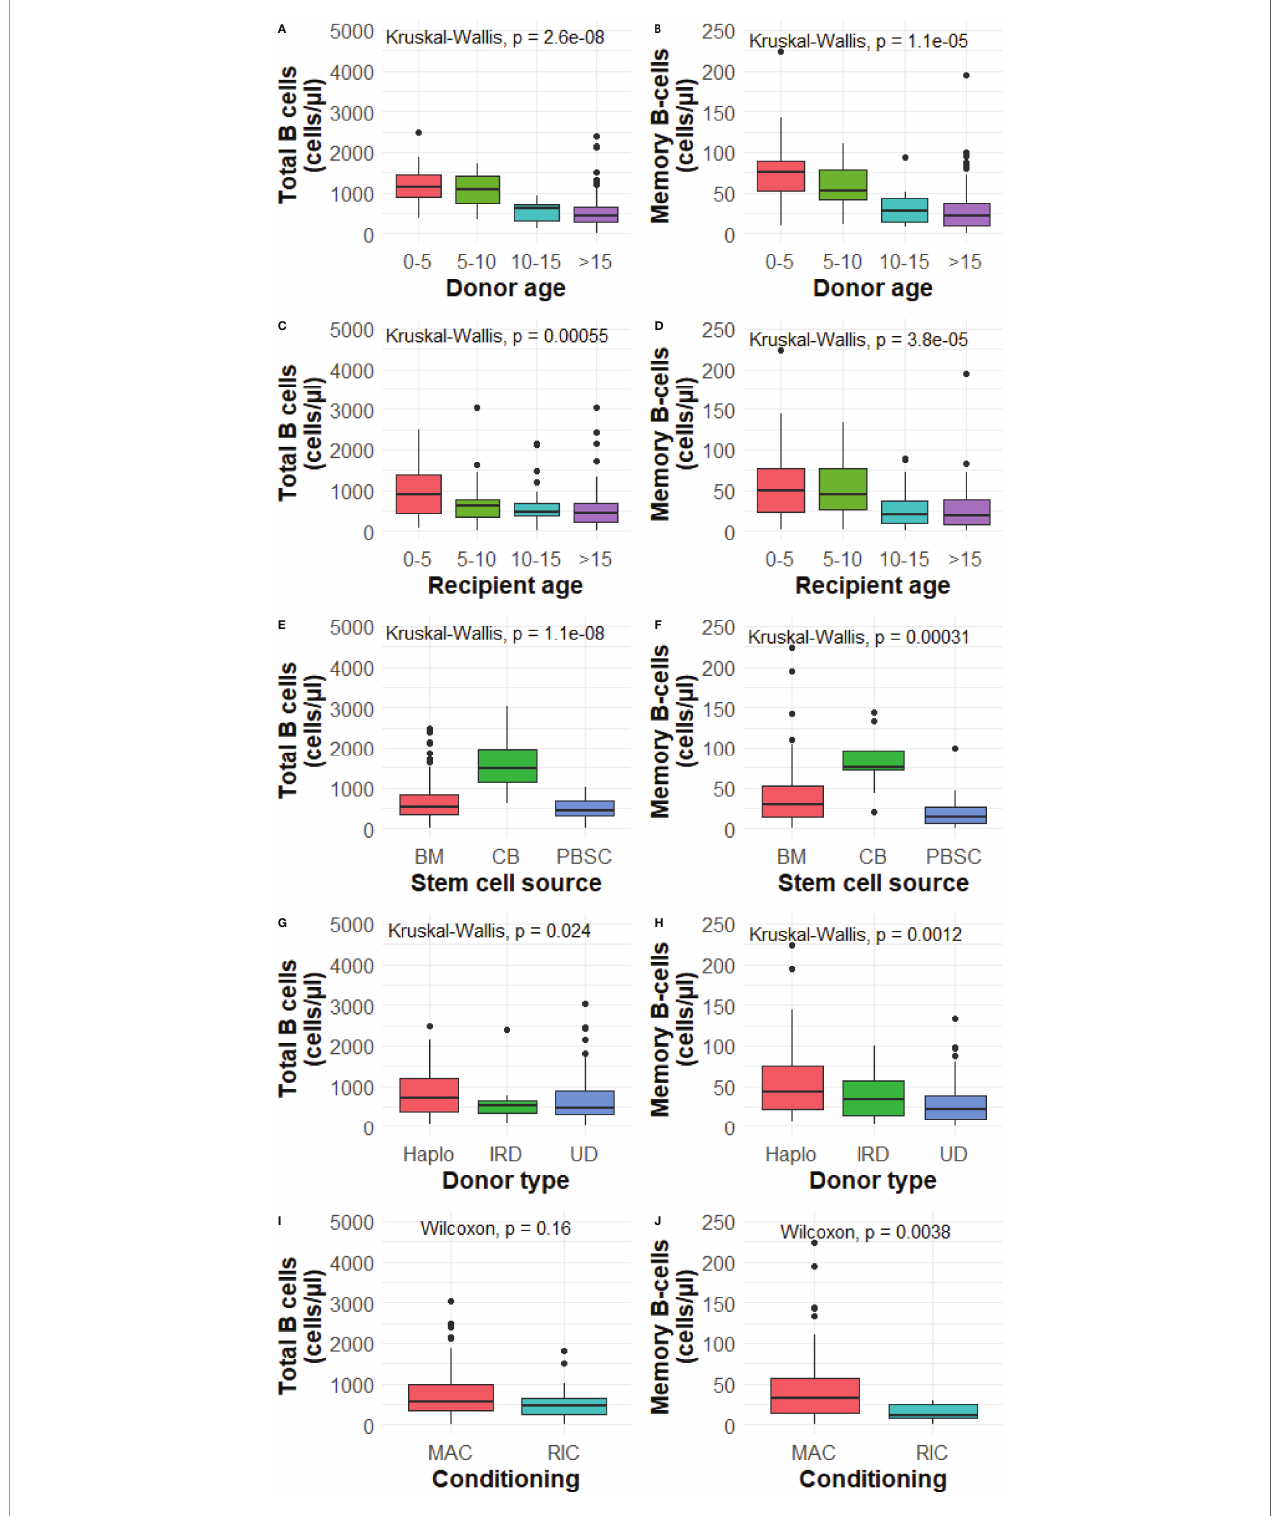
FIGURE 1 | (A – J) Determinant analysis at 1 year. BM, bone marrow; CB, cord blood; PBSC, peripheral blood stem cells; Haplo, haplo-identical; IRD, identical related donor; UD, unrelated donor; MAC, myeloablative; RIC, reduced intensity conditioning. P value from the Wilcoxon signed-rank test or Kruskal-Wallis test comparing categories and total and memory B-cell numbers. Data is presented as median with interquartile